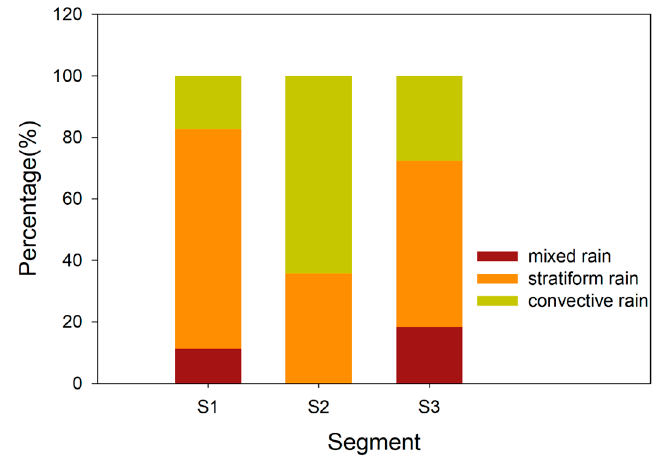
Figure 8. The percentage occurrence of the different rain types in the three segments.